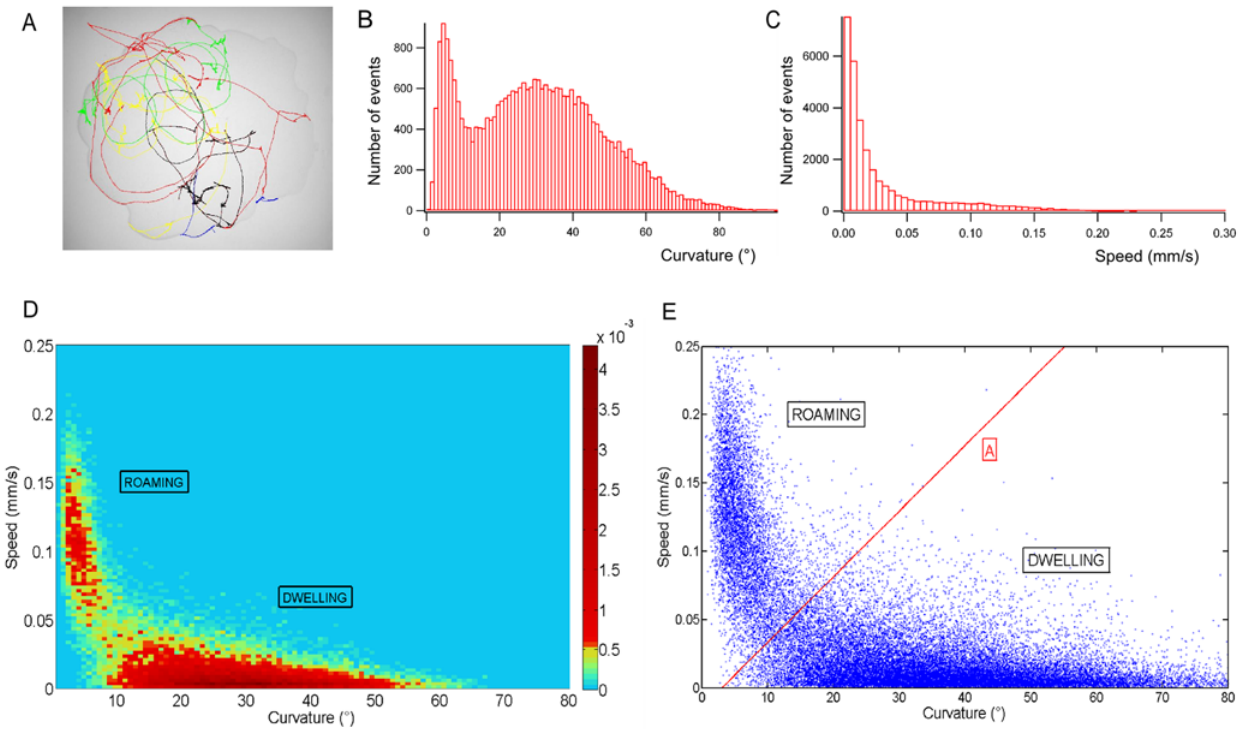
Figure 1. Two-state behavior of wild type C.elegans on food. (A) Trajectories of multiple WT C. elegans on OP50 (60 mm plate) (B) Curvature histogram for all the wild type worms (1bin=1 u ) (C) Speed histogram for all the wild type worms (1bin=0.05 mm/s) (D) Data points density map in the (Speed, curvature) plane. Two clusters can be observed (Data from 38 worms) (E) Clustering method. Data points over line A are attributed to the roaming phase, data points under line A to the dwelling phase. Line A has been determined on total WT data and is used for analysis of all the experiments in all the conditions.